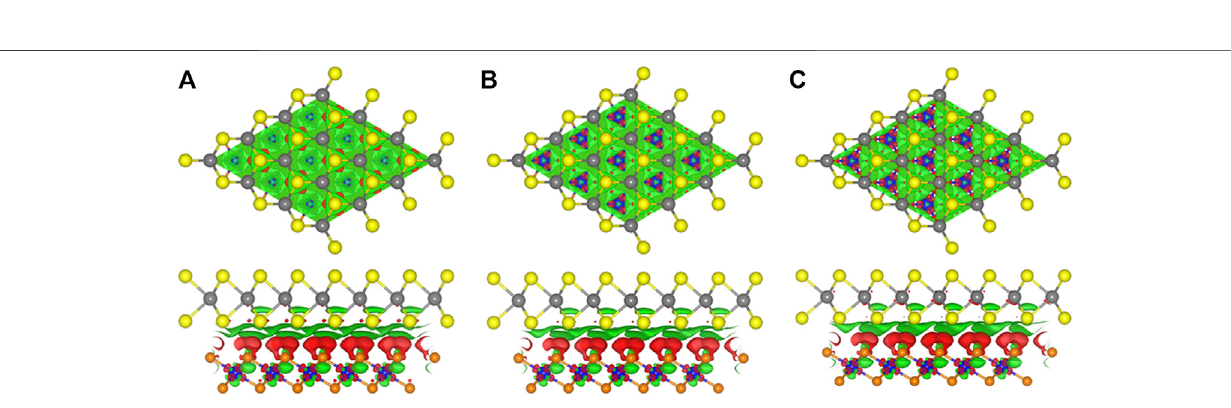
Frontiers in Chemistry |